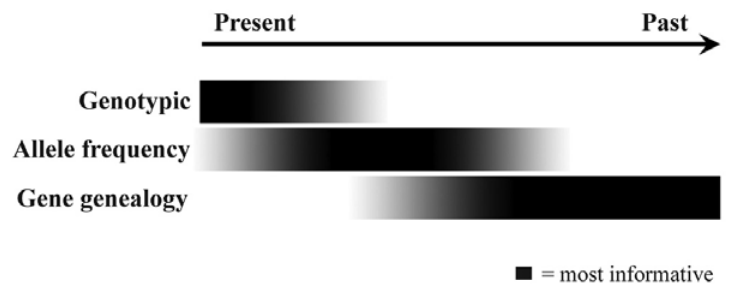
Figure 1. Three hierarchical levels of genetic information that can be obtained from diploid, co-dominant nuclear loci. Taken together, they cover a broad temporal spectrum, and the use of complementary analyses that focus on different ‘time slices’ of population history potentially allow these components to be